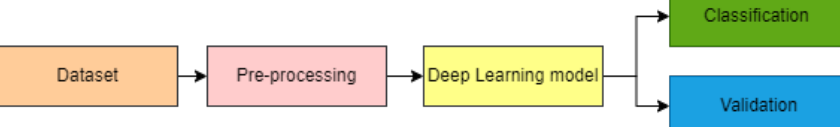
Figure 1. Workflow for classification and validation of TPDs.